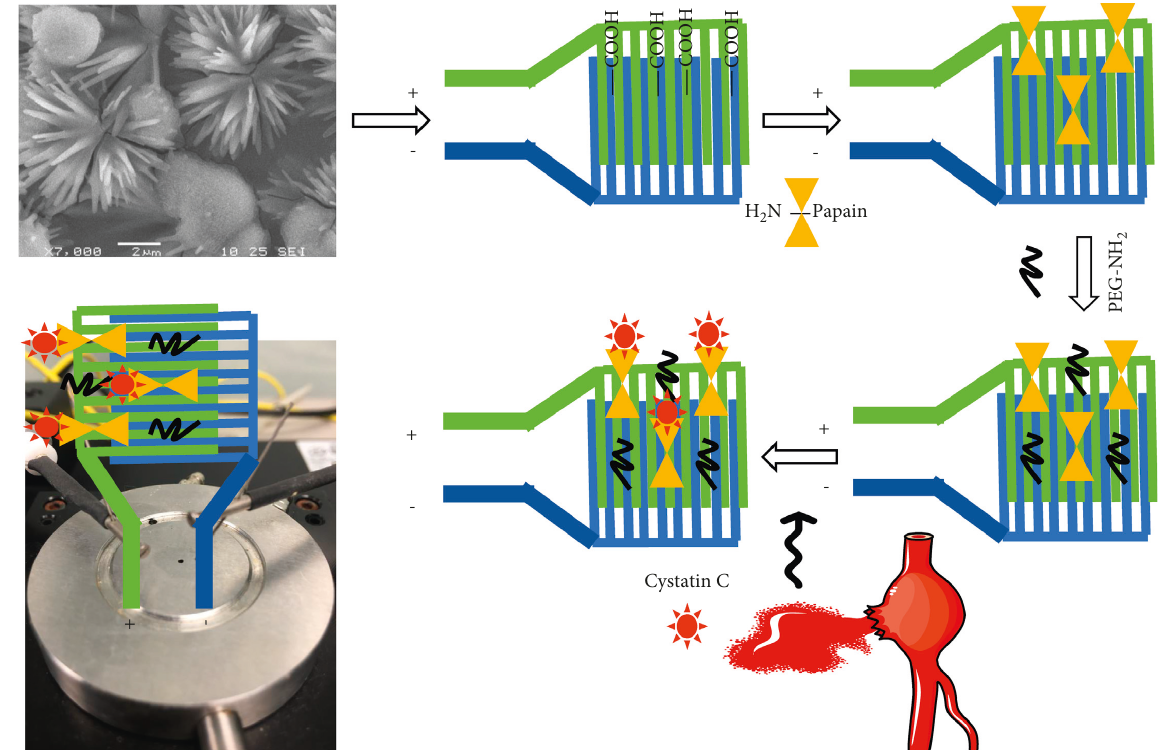
Figure 1: Schematic for surface modifications/functionalization. The different steps involved are shown. A dual probe station is displayed. The physical appearance of the aorta is also shown. The nanowire on the surface was evidenced by scanning electron microscope observation.